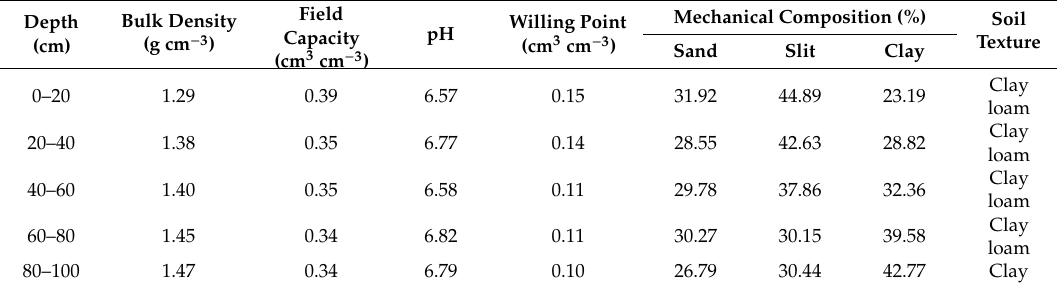
Table 1. Soil properties and taxonomic classification at di ff erent depths (0–100 cm) in May 2017. Soil texture are determined by the USDA (United States Department of Agriculture) textural soil classification